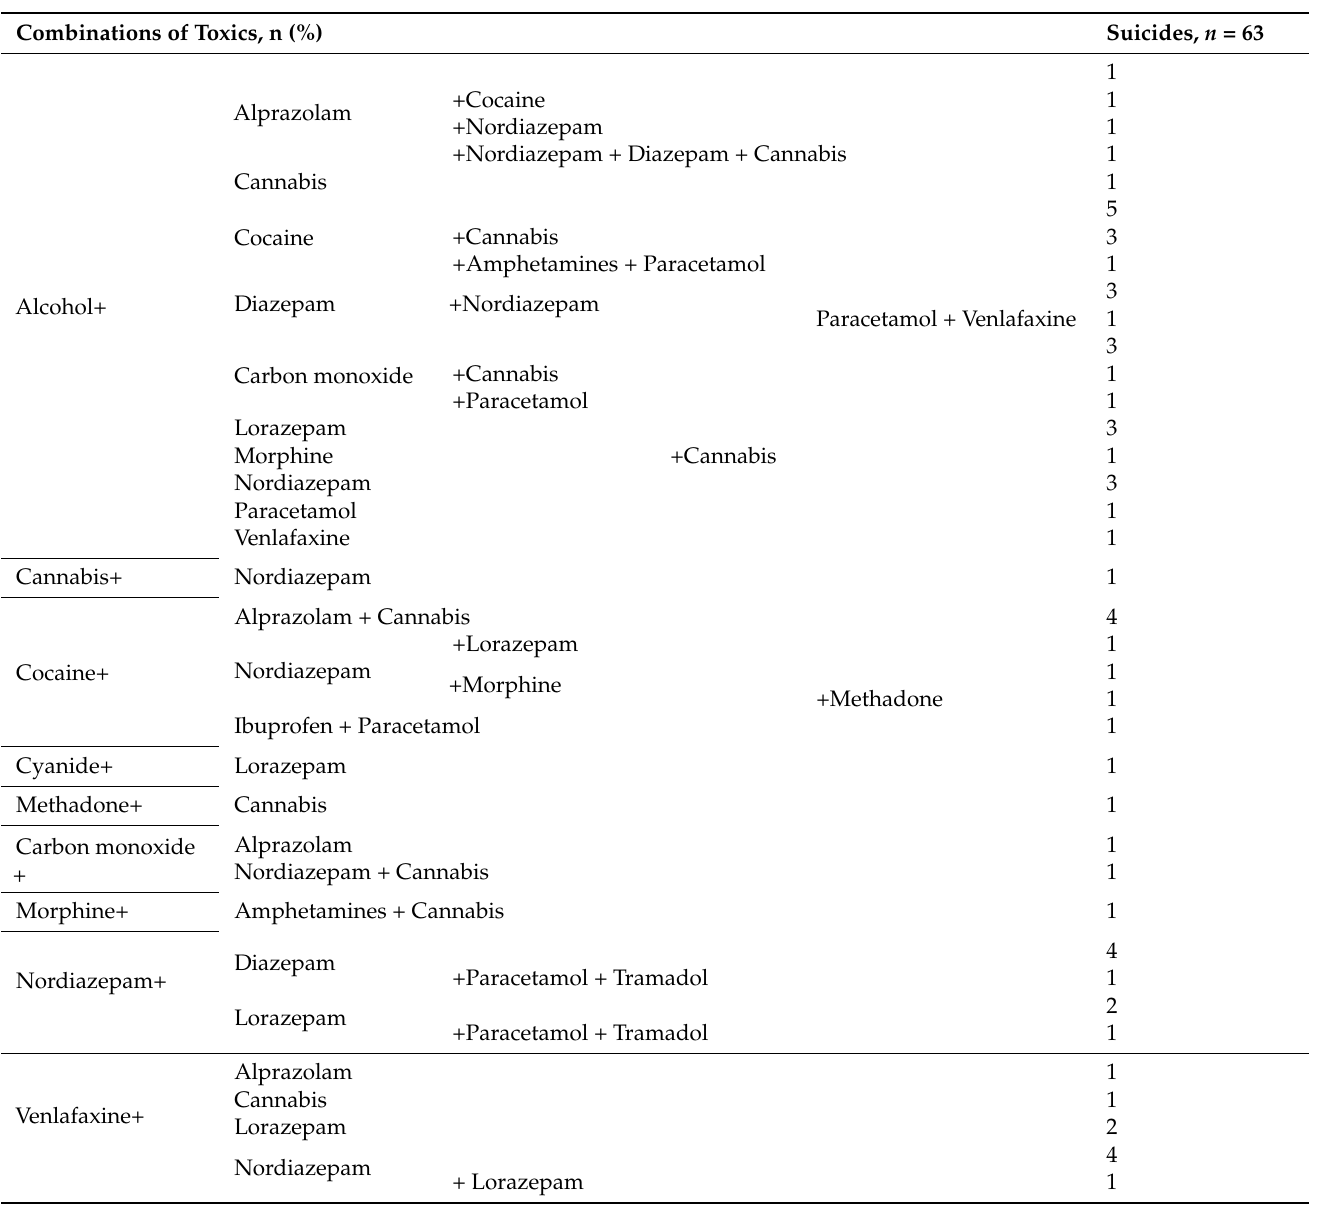
Table 4. Frequency of the combinations of toxics found in the suicides. Combinations of Toxics, n